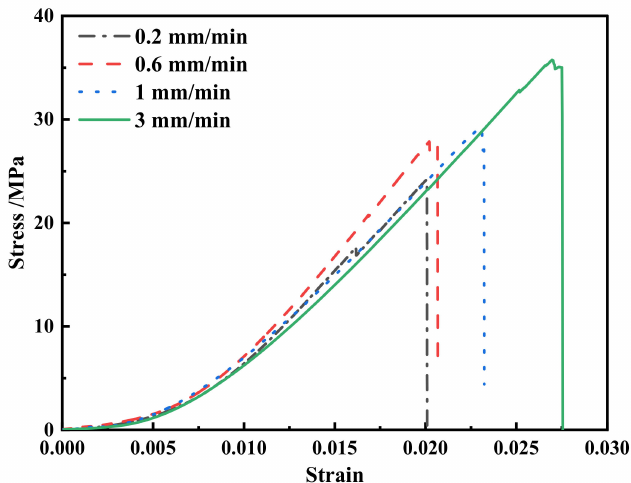
Figure 5. Uniaxial stress–strain curves of coal under various loading